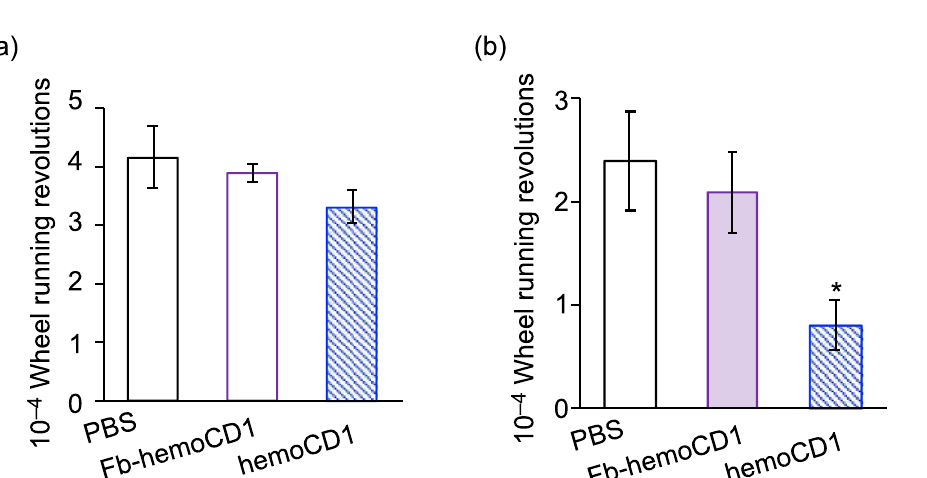
Figure 4. Cumulative wheel running revolutions in the first ( a ) and second 24 h periods ( b ) after i.p. administration of PBS, Fb-hemoCD1, and hemoCD1. Each bar represents the mean ± SE ( n = 3 mice per group). The mice were housed for two weeks under a 12 h light/dark (LD) cycle (lights on at 7:00 and light off at 19:00) until the day before the experiments. The mice were then housed under constant dark (DD) conditions during the observations. Asterisk denotes statistical significance ( * P < 0.05), as compared to the controls. The raw actograms for measuring the wheel running activity are shown in Fig.